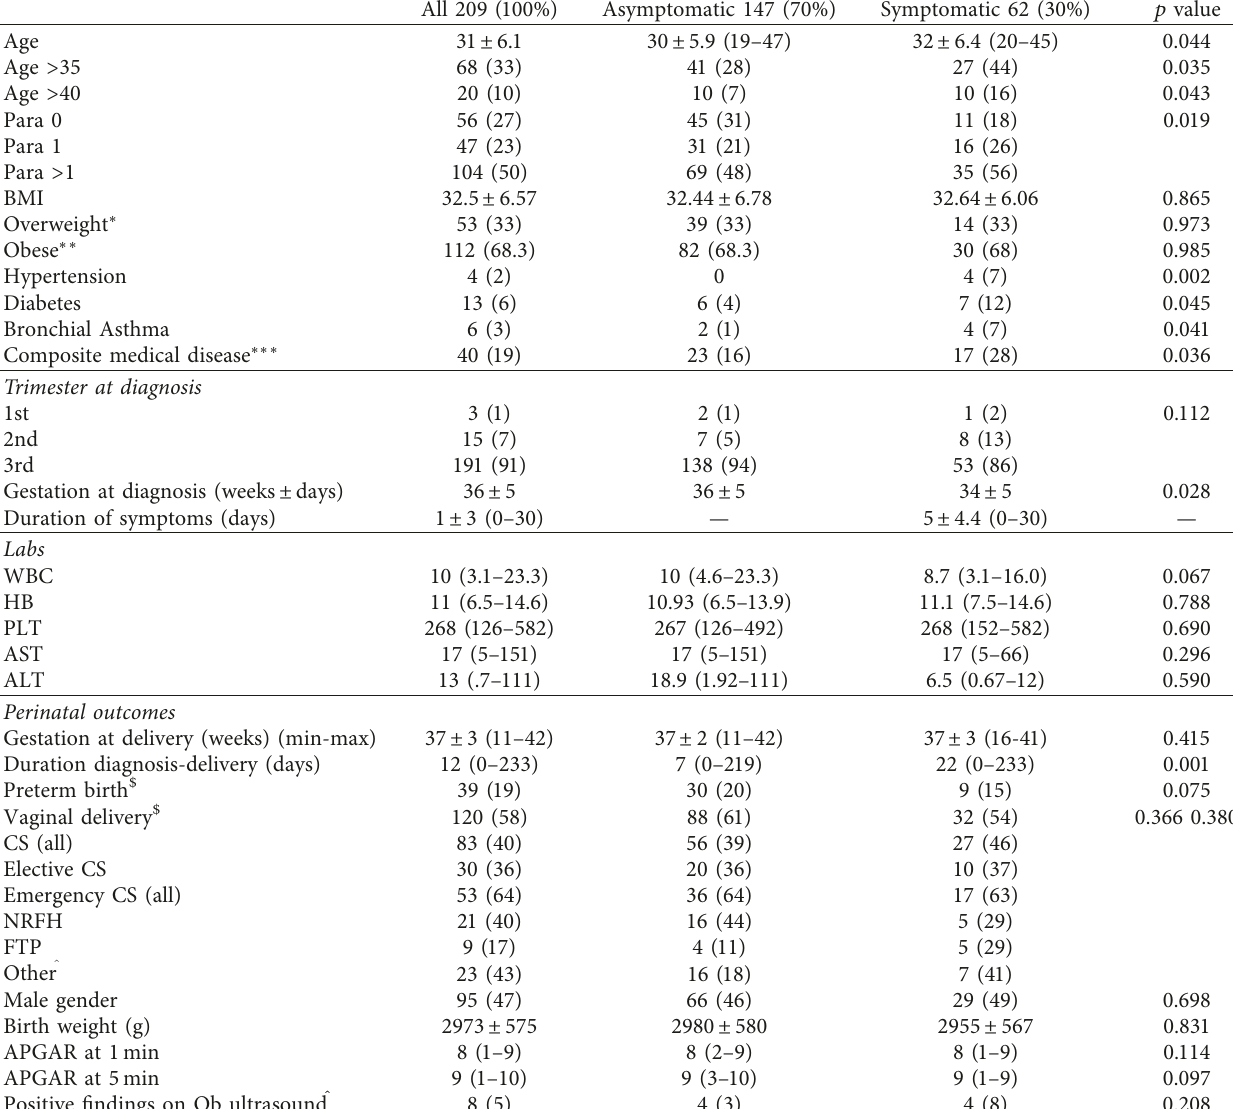
Table 2: Maternal characteristics, investigations, and pregnancy